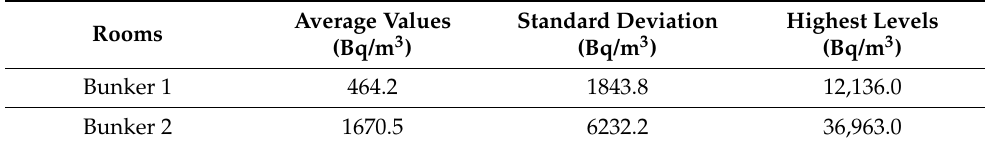
Table 2. Average values, standard deviation and highest levels of radon detected in the radiother- apy bunkers.